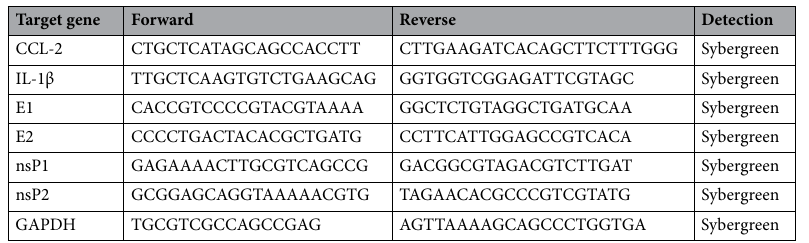
Table 1. Primers used for qRT-QPCR